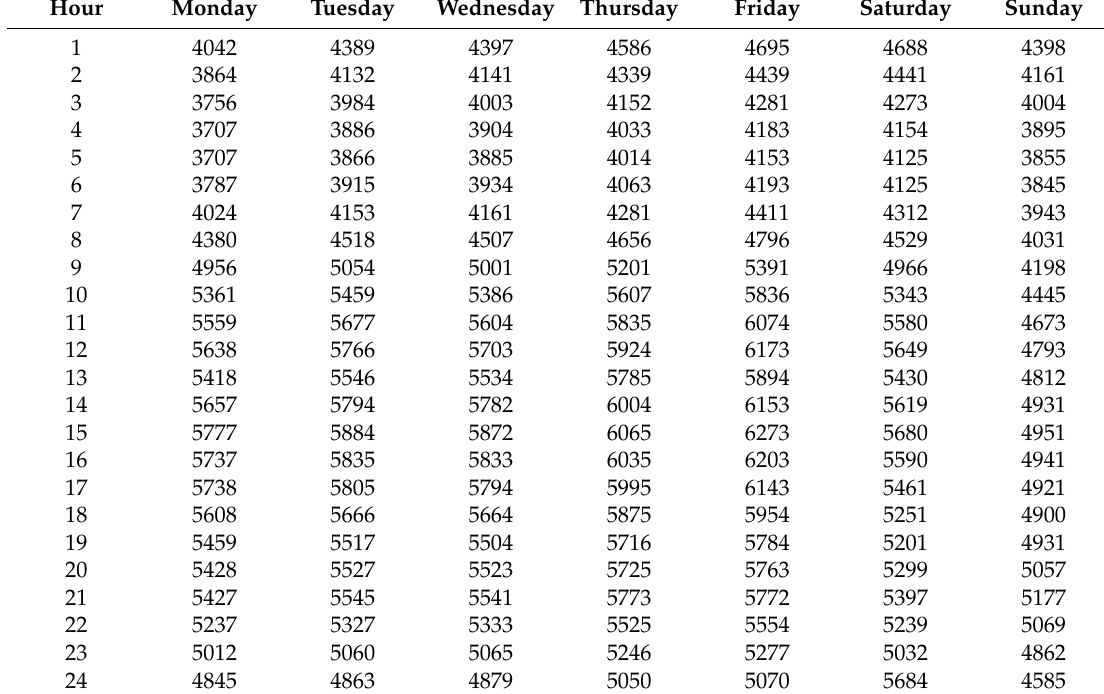
Table A1. Forecasted demand for peak-shaving/load-leveling (MW) [23].